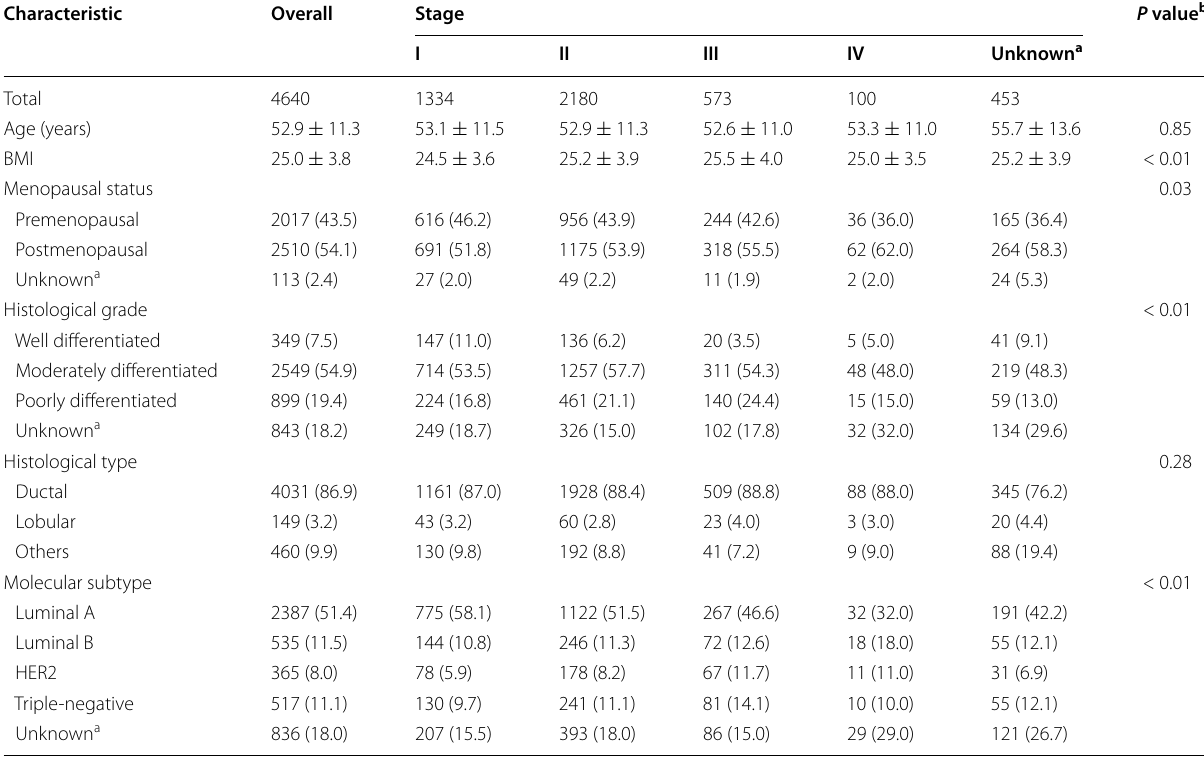
Continuous data are expressed as mean standard deviation (SD). Categorical data are expressed as number of cases (percent) ± a Unknown data were not included in the statistical tests b P values were calculated using one-way analysis of variance (ANOVA) test (continuous variables) and Chi square or exact test (categorical